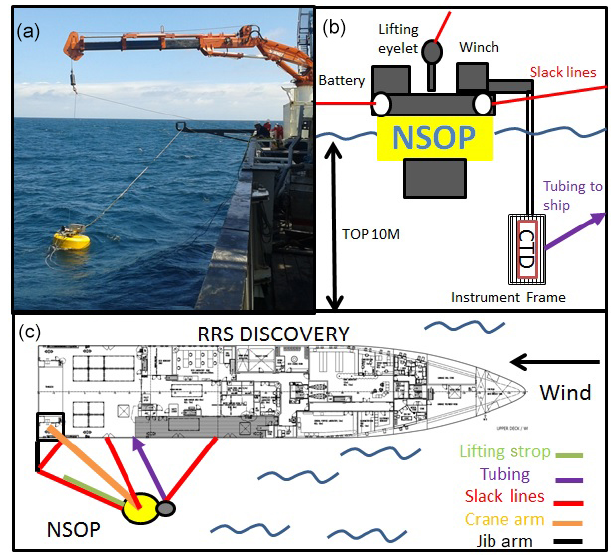
Figure 1. Different points of view of an NSOP deployment: (a) im- age from a deployment on RRS Discovery in May 2015 (Cruise DY030), (b) schematic cross section of NSOP including tubing back to ship (purple) and slack lines (red), and (c) top-down schematic from a research ship including ship orientation. Not to